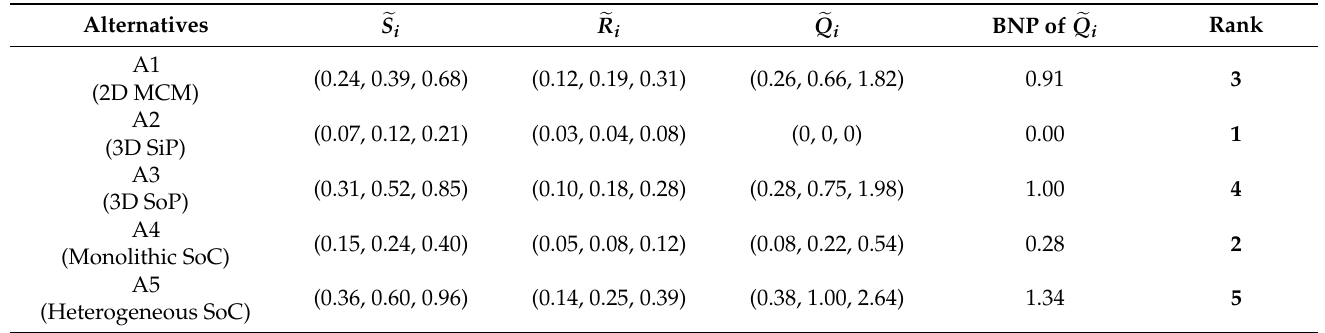
Table 10. Performance ratings of the alternatives. MCM, multi-chip module; SiP, system-in-package; SoP, system-on-package; SoC, system-on-chip; BNP, best nonfuzzy